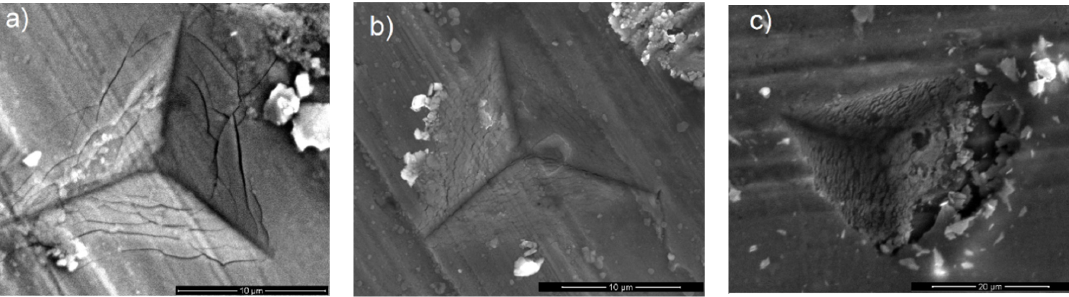
Figure 6. SEM images of 40 mN load effect on the layers ( a ) RT, ( b ) 200 ◦ C, and ( c ) 300 ◦